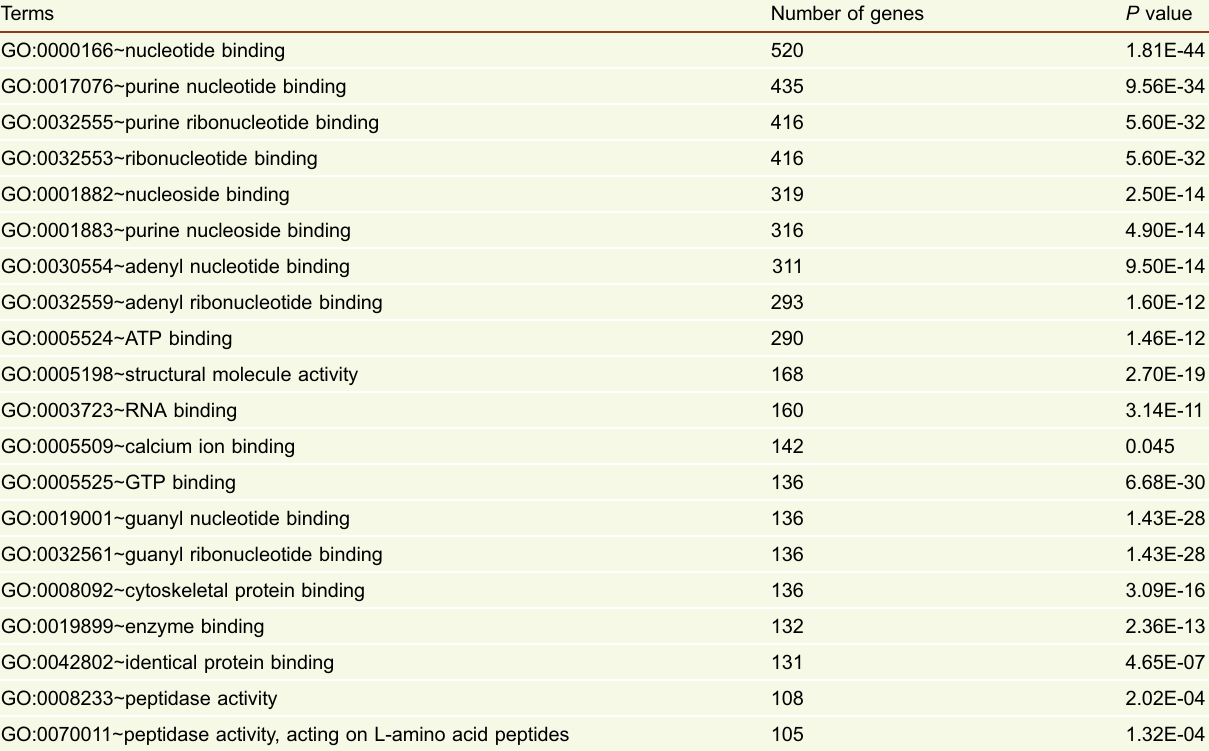
Table 1. Top 20 terms in molecular function category